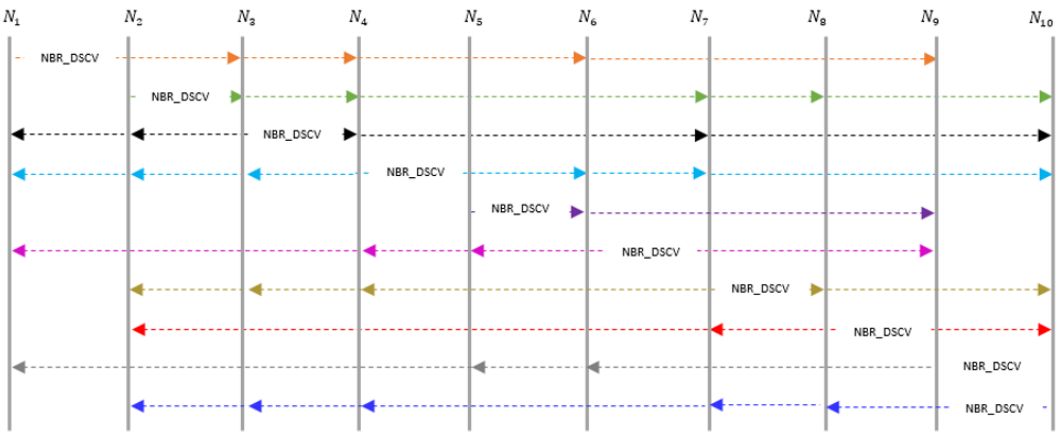
Figure 6. Flow diagram of one-time neighbor discovery process for N nodes, where N = {1, 2, 3, ... ,